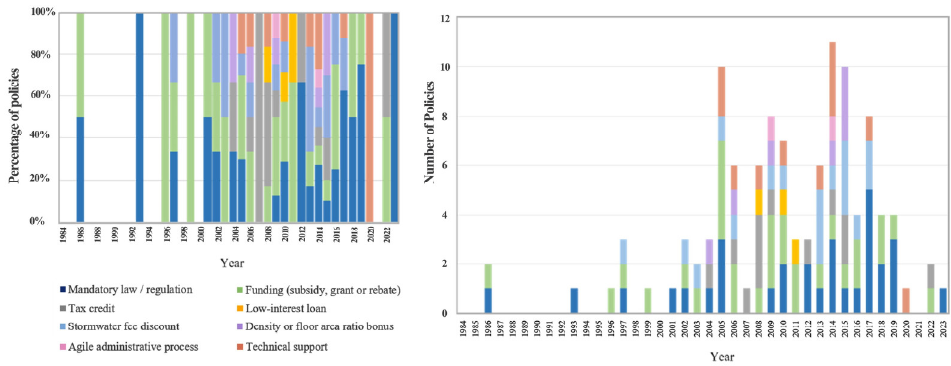
Figure 8. Comparison of financial incentives provided by different cities.